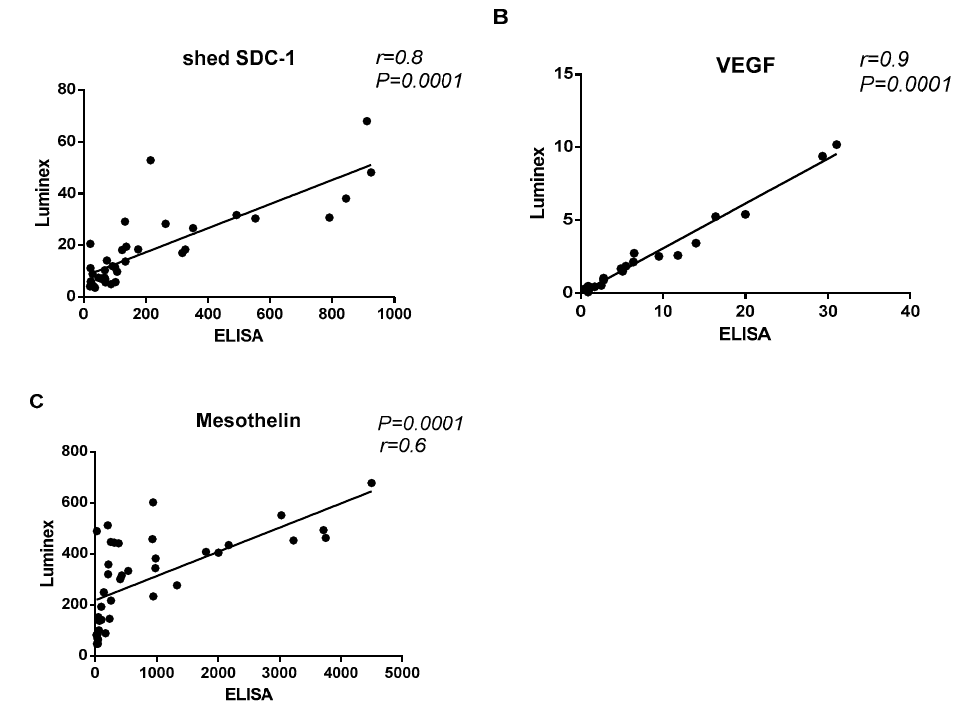
Figure 1. Correlation between enzyme-linked immunosorbent assay (ELISA) and Luminex. ( A ) Correlation between shed Syndecan-1 (SDC-1) level in pleural effusion measured by ELISA and Luminex. ( B ) Correlation between VEGF level in pleural effusion measured by ELISA and Luminex. ( C ) Correlation between Mesothelin level in pleural effusion measured by ELISA and Luminex. Spearman correlation analysis was used to assess the correlation between these two immunoassays.